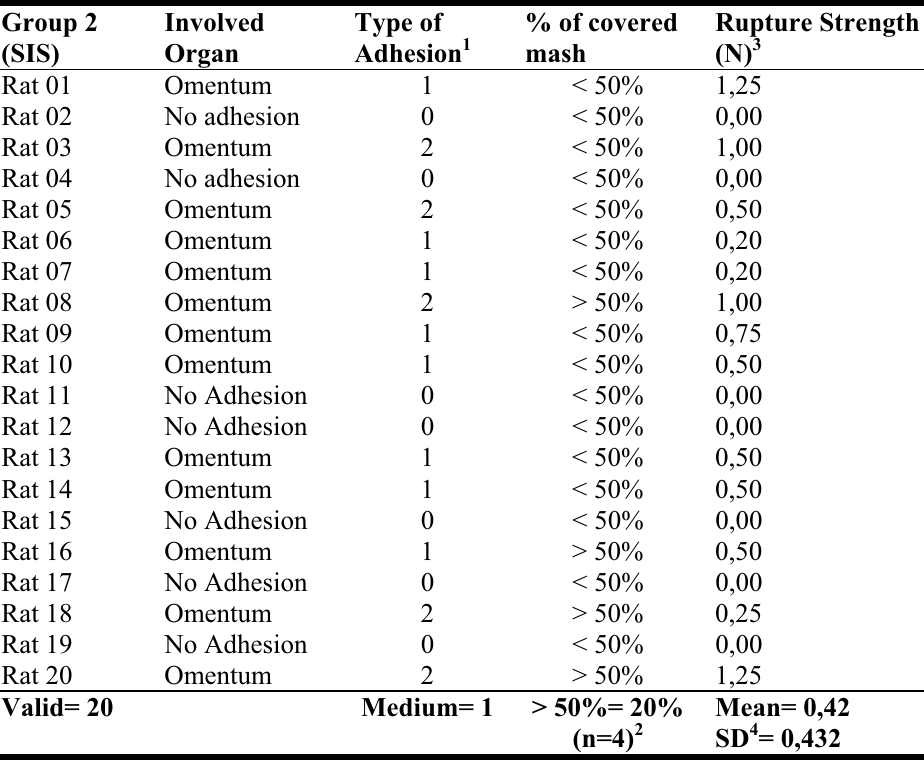
TABLE 3 - Results obtained for Group 2